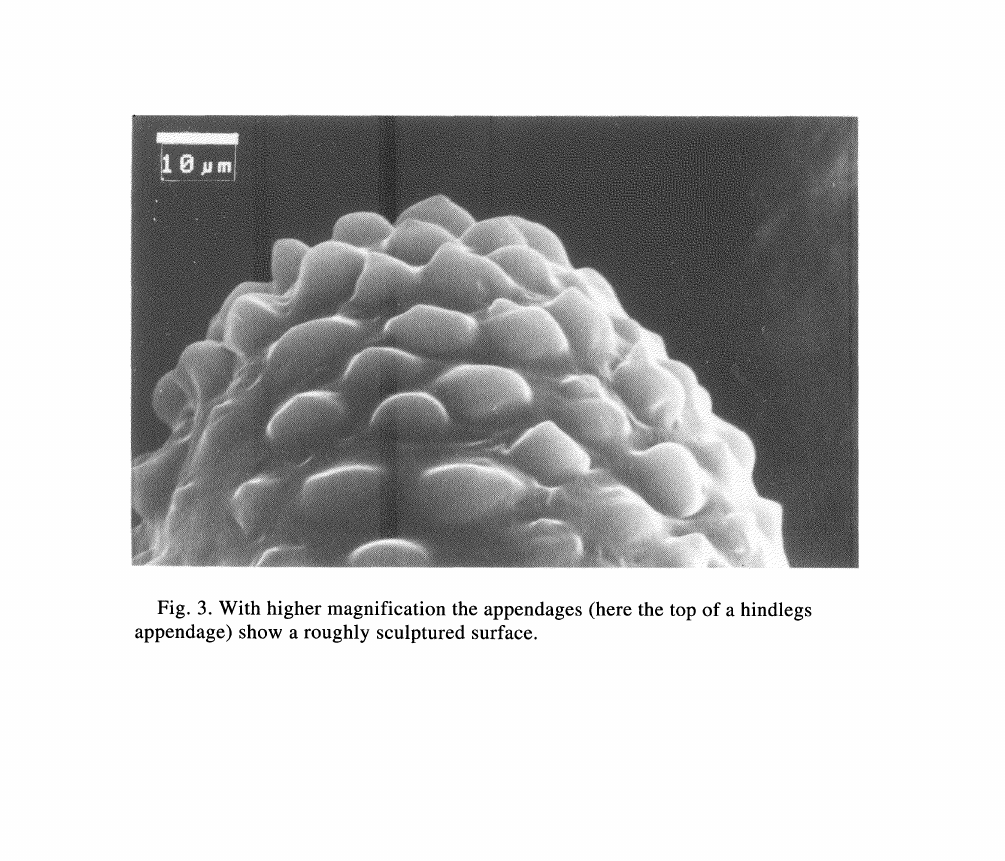
Fig. 2. Lateral view of the petiole appendages.